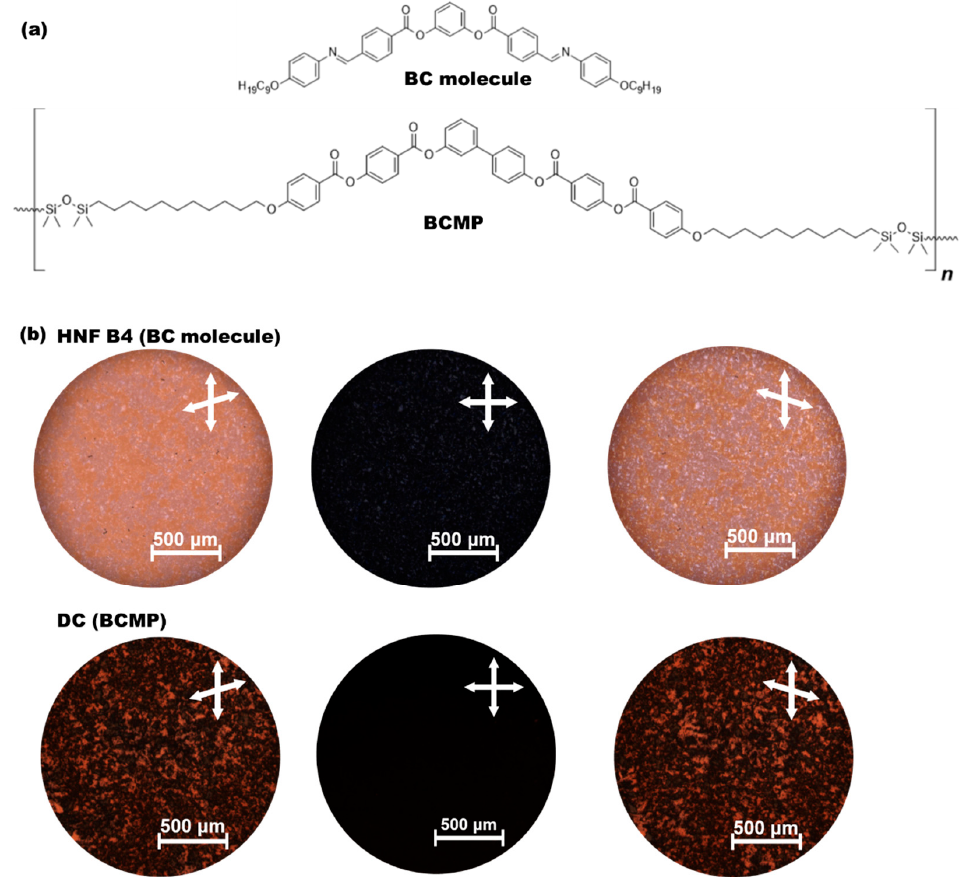
Figure 1. ( a ) Chemical structures of the BC molecule and BCMP used in this study. ( b ) Typical POM images of the HNF B4 phase (BC molecule) and DC phase (BCMP).